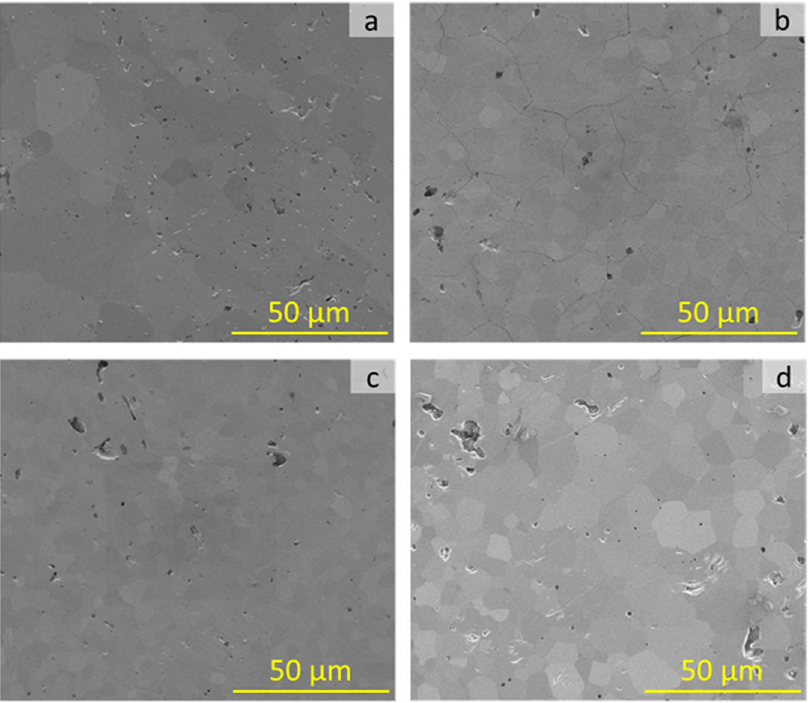
Fig. 3 SEM observation of homogeneous materials before alteration. SEM micrographs of polished pellets of homogeneous materials (SE mode) before leaching: a UO 2 ; b U 0.92 Ce 0.08 O 2 ; c U 0.88 Ce 0.12 O 2 ; d U 0.75 Ce 0.25 O 2